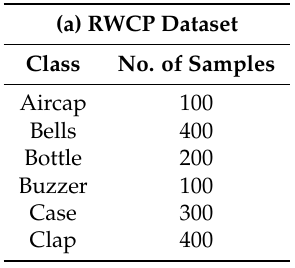
Table 2. Details of Individual Classes of RWCP and DCASE